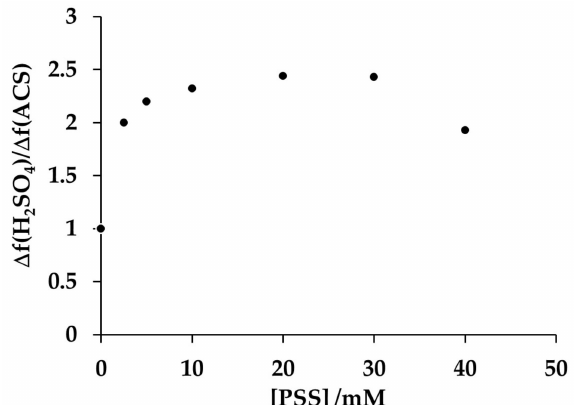
Figure 7. E ff ect of the PSS concentration in the work solution on the ratio of the total frequency shift using H 2 SO 4 and HCS, ∆ f(H 2 SO 4 ) / ∆ f(HCS), which were obtained from Figure